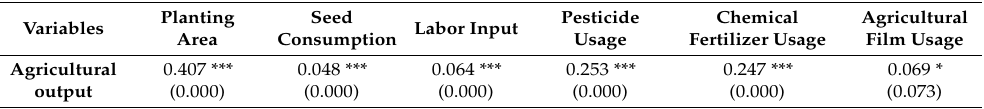
Table 1. Pearson correlation for inputs and